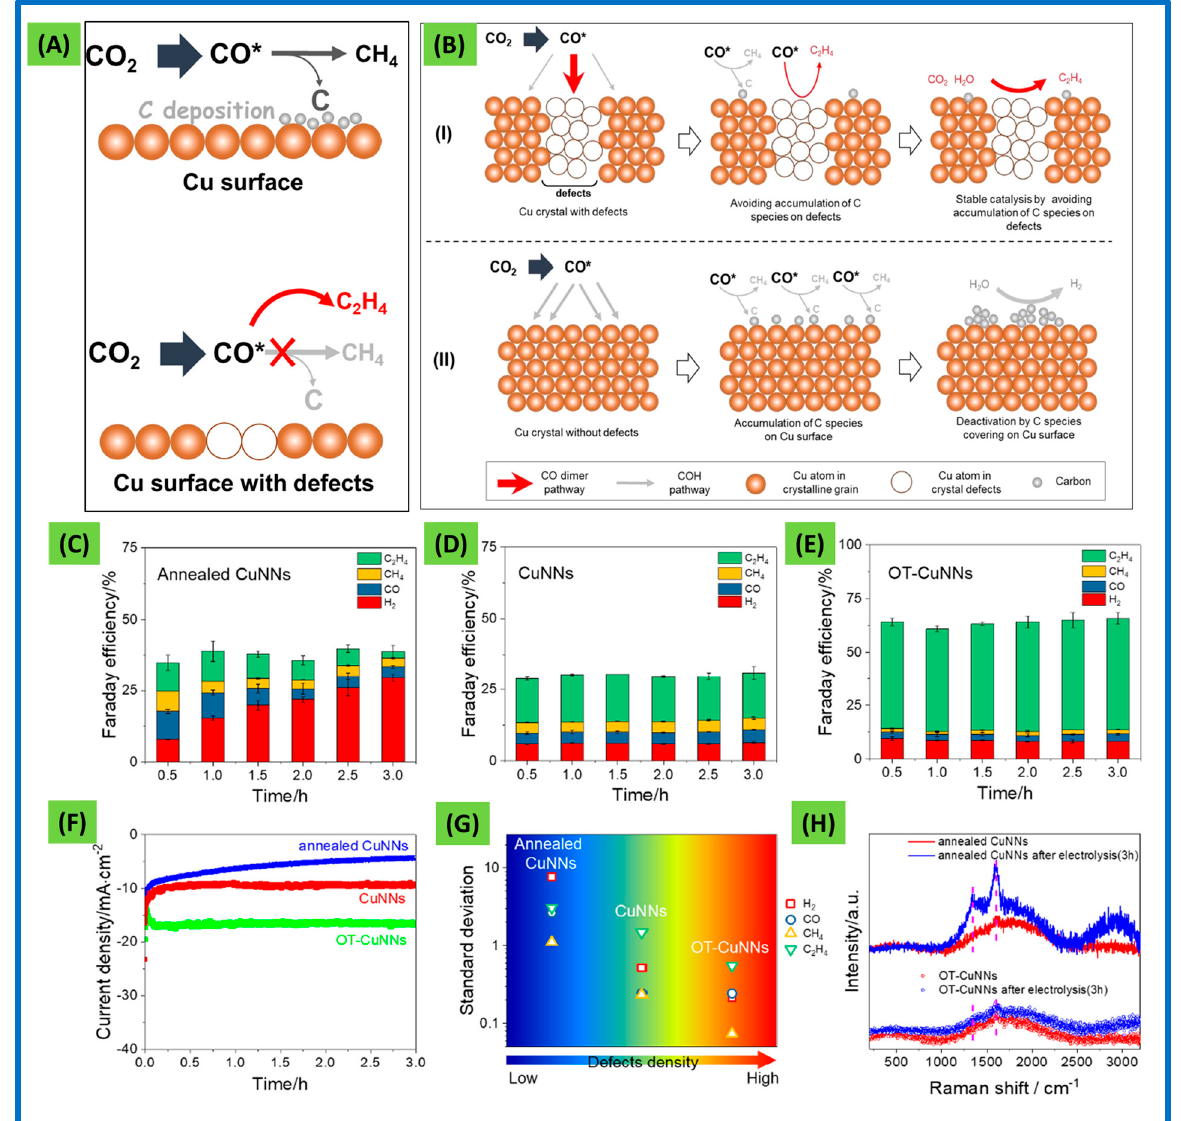
Figure 6. ( A , B ) Schematic illustration of a plausible mechanism for (I) deactivation process on a Cu surface without crystal defects and (II) stable catalysis on a Cu surface containing crystal defects during the CO 2 -RR. FEs of various Cu electrodes: ( C ) annealed CuNNs; ( D ) CuNNs; ( E ) OT-CuNNs; and ( F ) their corresponding current density vs. time curves. ( G ) Correlations between the standard deviations of the FEs for various C 2 products on the different Cu electrodes and the number of defects. ( H ) Raman spectra of the different electrodes before and after electrolytic reactions [108] (copyright: Elsevier, 2019). Table 1. Single- and bimetallic-material-based electrocatalysts for electrochemical CO 2 -RR.